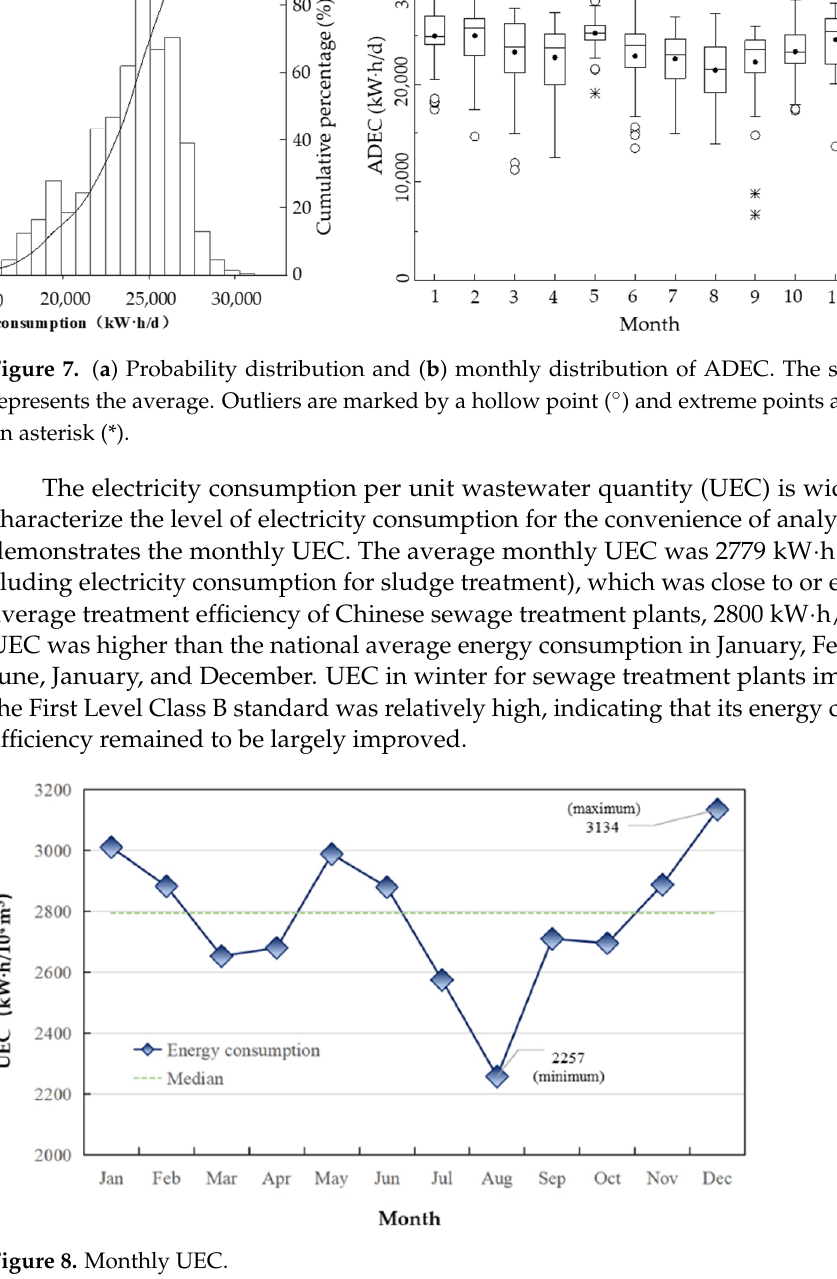
Figure 8. Monthly